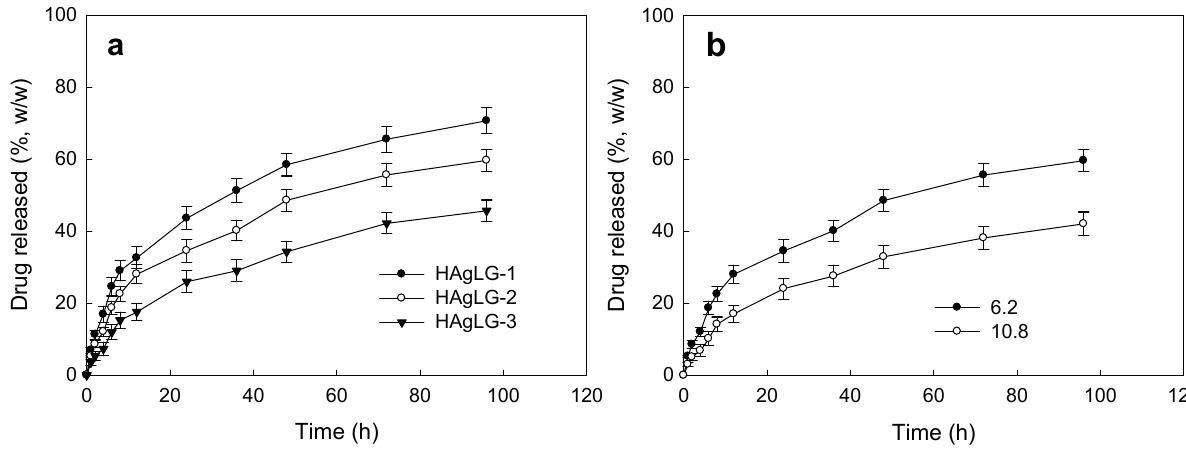
Figure 4. DOX release from HAgLG polymeric micelles. The effect of PLGA contents in the copolymer ( a ); drug contents in the polymeric micelles ( b